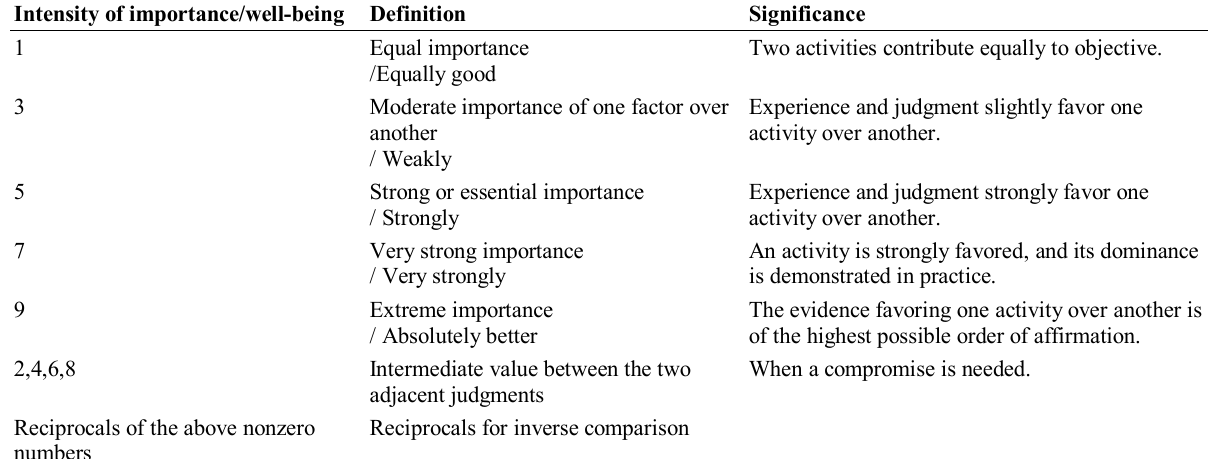
Table 1: 9-point intensity of relative weight (importance or well-being)